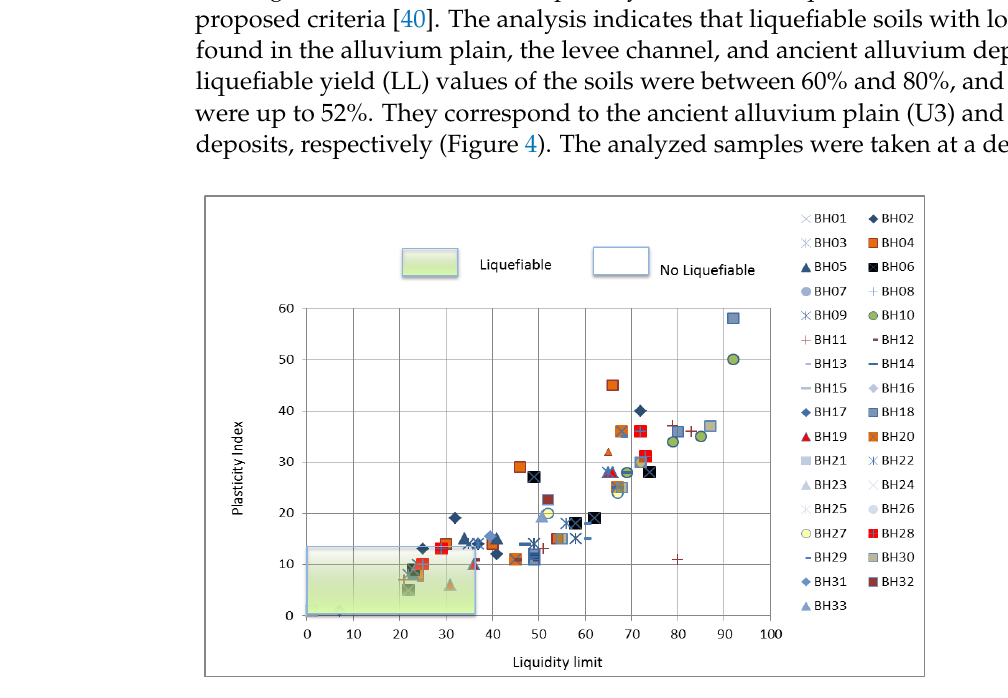
Figure 5. Analysis of the liquefaction susceptibility based on the criteria proposed by Seed et al. [40]. The green rectangle is distributed spatially to determinate the areas susceptible to soil liquefaction, while the white area indicates the non-liquefiable soils. The circles represent the